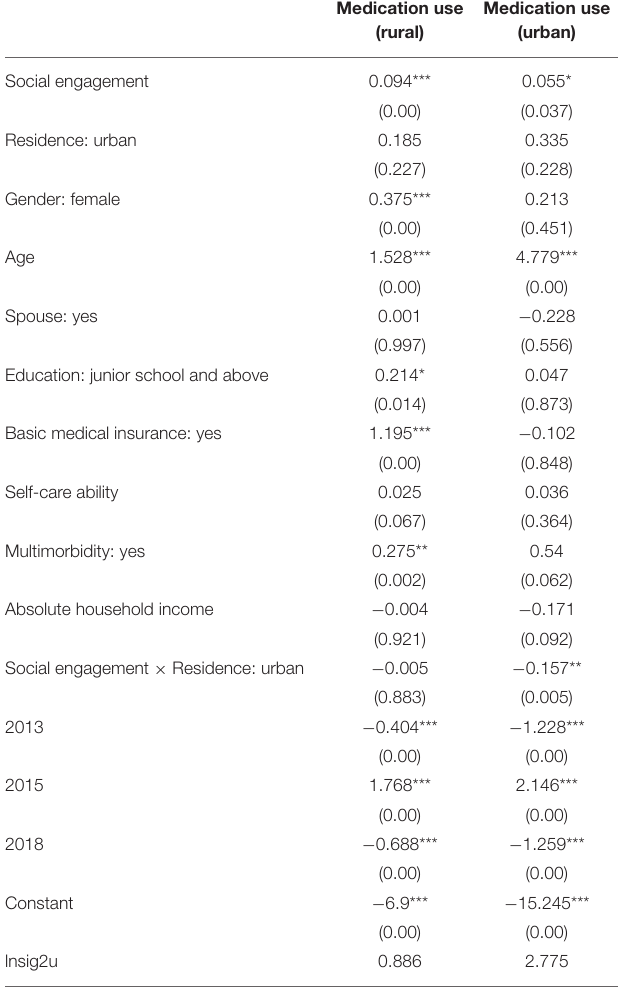
TABLE 7 | Random-effect panel logit regressions reporting the effect of population mobility on social engagement among urban and rural patients in medication use